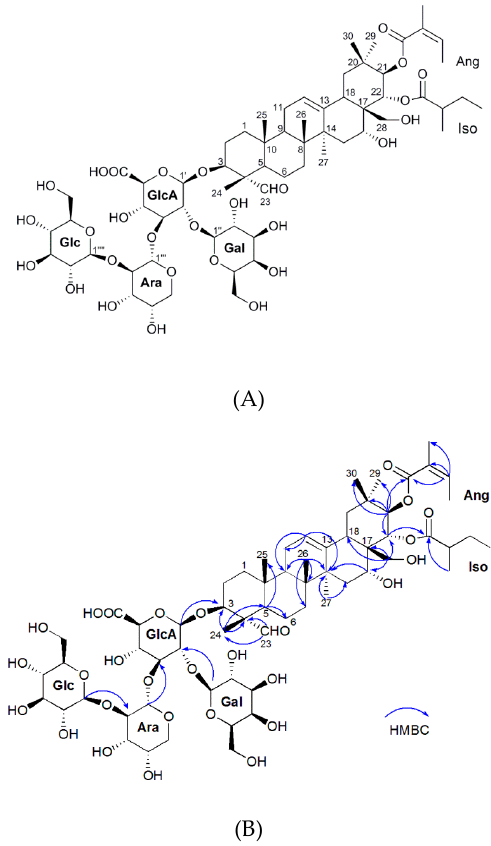
Figure 3. The relative expression of genes related to fatty acid metabolism on fatty acid synthesis genes ( SREBP-1c, FAS and ACC ) and fatty acid β -oxidation genes ( PPAR α , ACOX-1 and CPT-1 ). NC, blank control; OA, 80 μ M oleic Acid; OA + SVST, 80 μ M Oleic Acid + 10 μ M simvastatin; OA + A 2 , 80 μ M Oleic Acid + 10 μ M Oleiferasapoin A 2 . Compared to the control, ** p < 0.01.